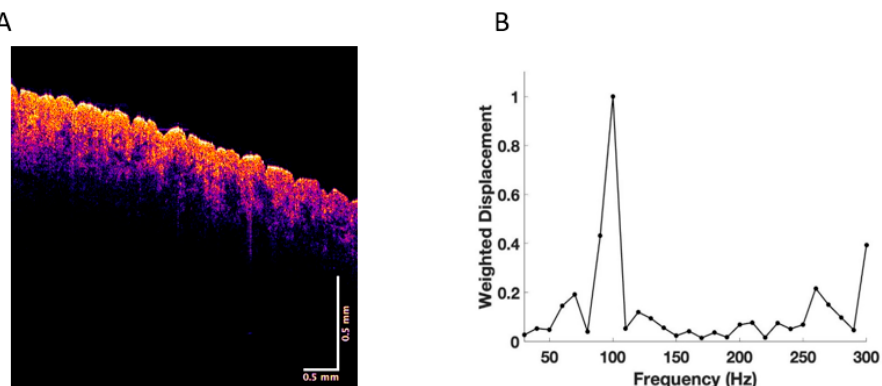
Figure 1. ( A ) Color-coded OCT image of normal skin showing the epidermis in yellow and pink and the papillary dermis in blue. ( B ) Plot of weighted displacement versus frequency for normal skin showing the cellular (60–80 Hz), papillary collagen fibers (100), and a small fibrotic peak (250–260 Hz).